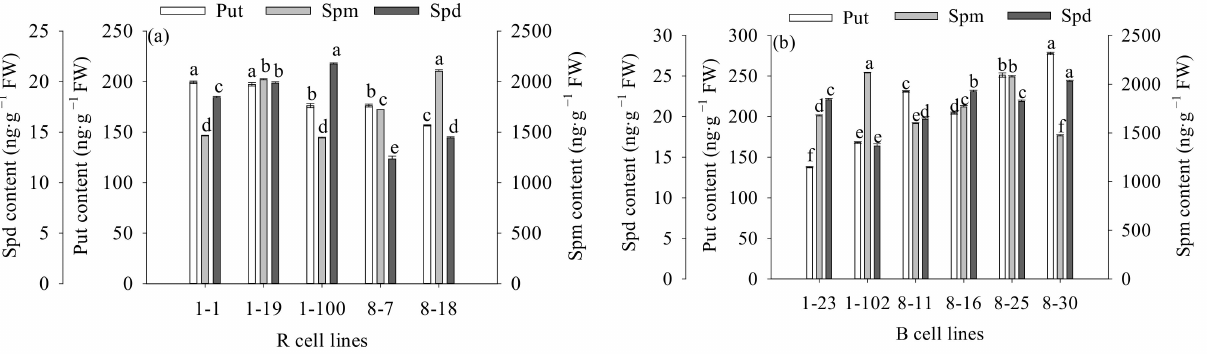
Figure 13. Differences in Put, Spd, and Spm contents between different cell lines of P. koraiensis . ( a ) R cell lines; ( b ) B cell lines. Different letters above the columns indicate significant differences at the p < 0.05